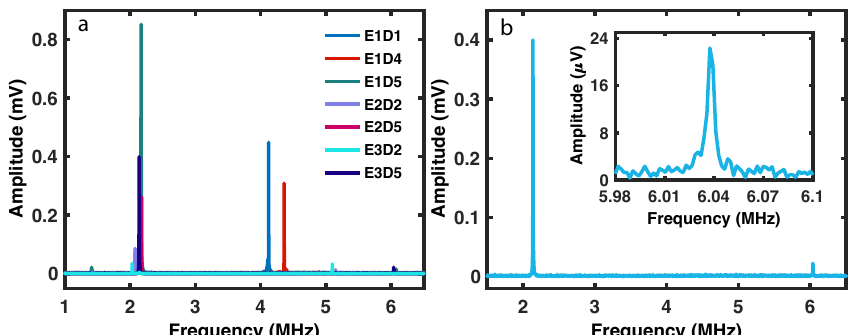
Figure 14. Resonance spectra of nanoparticle circles on SOI devices under vacuum conditions at room temperature. ( a ) Torque amplitude of various devices with nanoparticles. ( b ) Resonance spectrum of an individual device. Inset shows the Lorentzian shape of the resonance curve for the higher frequency